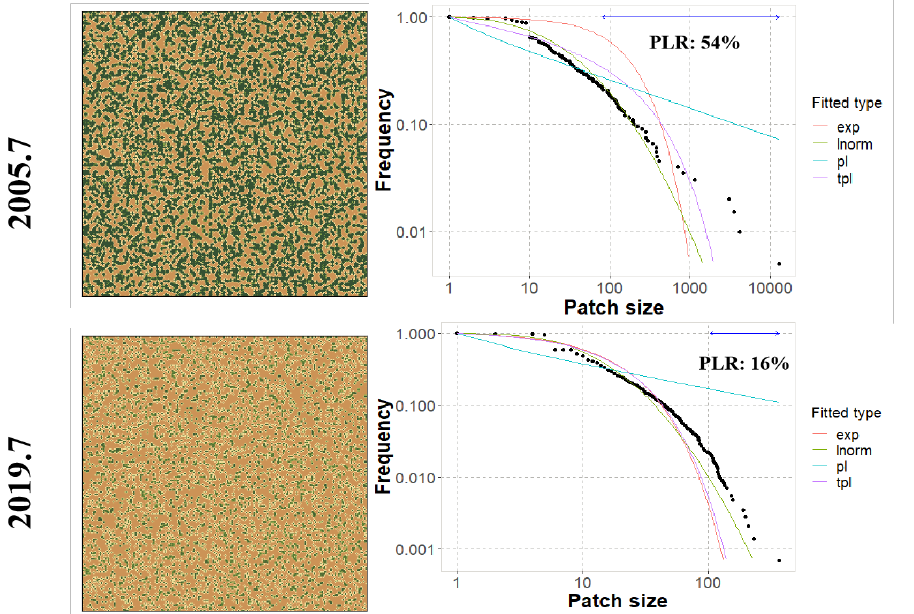
Figure 9. The PLR of the simulated vegetation patterns for 2005 and 2019. Red line: exponential fitting. Green line: lognormal fitting. Blue line: power law fitting. Purple line: truncated power law